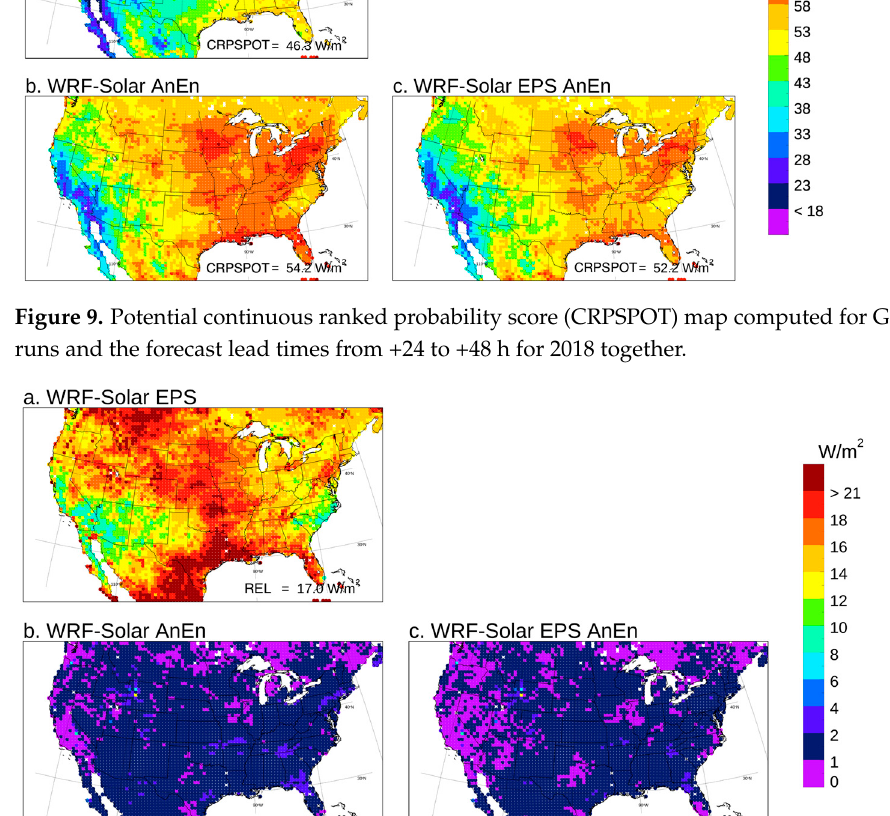
Figure 10. Reliability (REL) map computed for GHI pooling runs and the forecast lead times from +24 to +48 h for 2018 together.